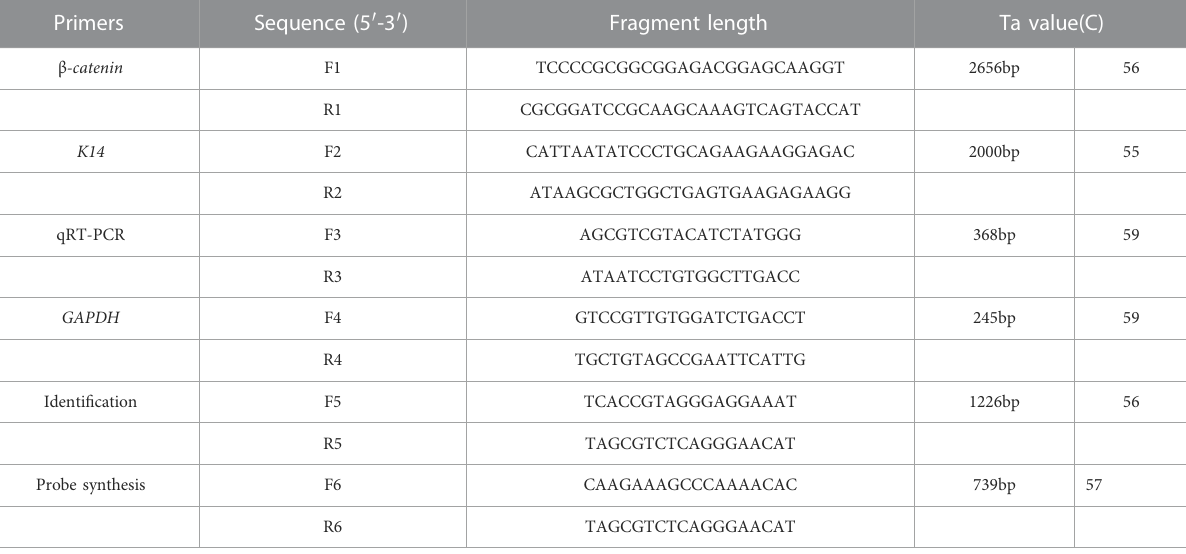
TABLE 1 Primer sequences used to produce transgenic mice. F1, R1 for the ampli fi cation of β -catenin. F2, R2 for the ampli fi cation of promoter K14. F3, R3 for the qRT-PCR of transgenic mice. F4, R4 for the ampli fi cation of housekeeping gene. F5, R5 for the identi fi cation of positive mice. F6, R6 for the synthesis of probe of Southern blot. The underlined bases are the restrict enzyme